Question: What type of chart is this?
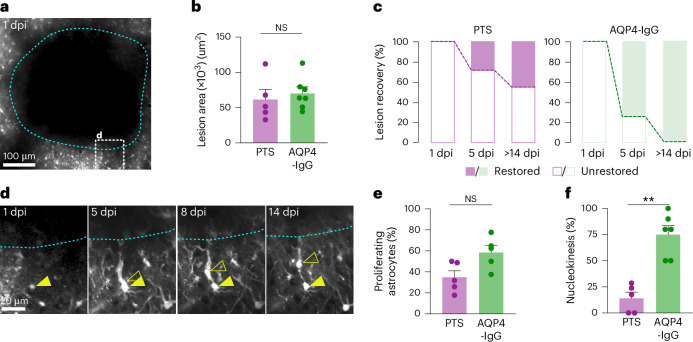
Answer: line